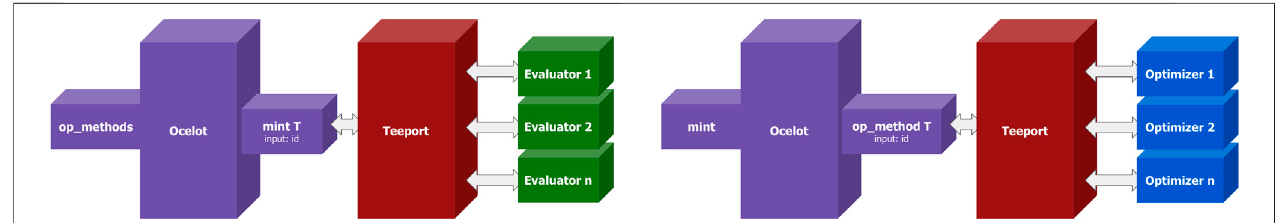
FIGURE 13 | Teeport as an Ocelot plugin. Left: Extending the machine interfaces in Ocelot through Teeport; Right: Extending the optimization methods in Ocelot through Teeport.